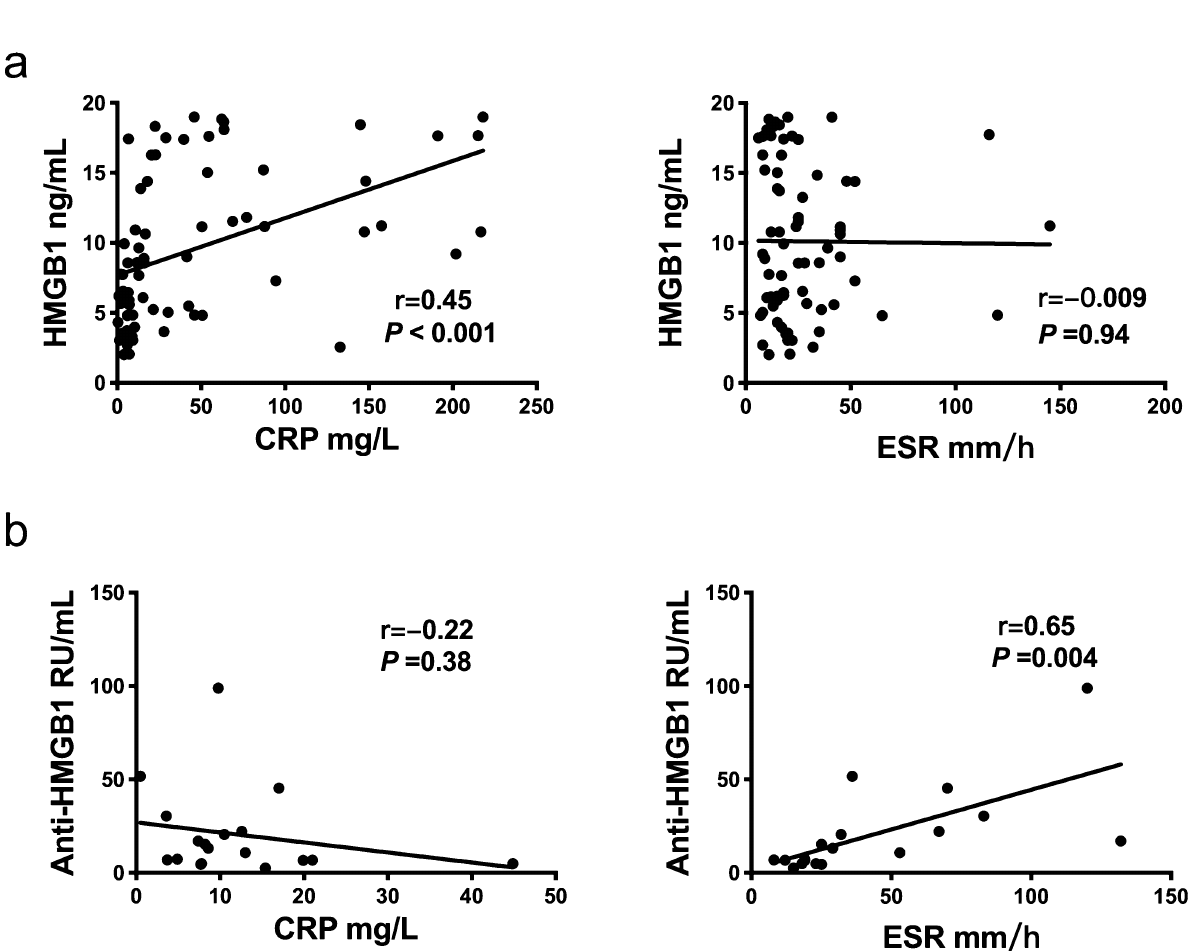
Figure 3. Correlation analysis of serum HMGB1 or anti-HMGB1 antibodies with disease severity markers in patients with FUO. ( a ) Serum HMGB1 is correlation with CRP and ESR in patients with FUO; ( b ) Serum anti- HMGB1 antibodies is correlation with CRP and ESR in patients with